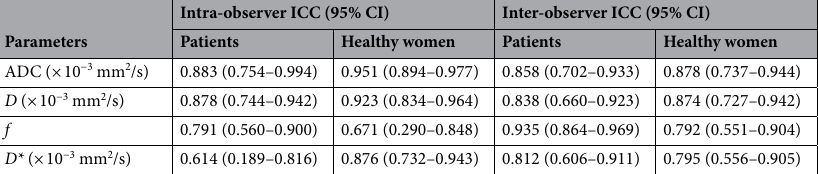
Table 4. Intra- and inter-observer agreements in the measurements of IVIM parameters of endometrium in patients and healthy women. ADC apparent diffusion coefficient, D true diffusion coefficient, f perfusion fraction, D* pseudo-diffusion coefficient, ICC intraclass correlation coefficient, CI confidence